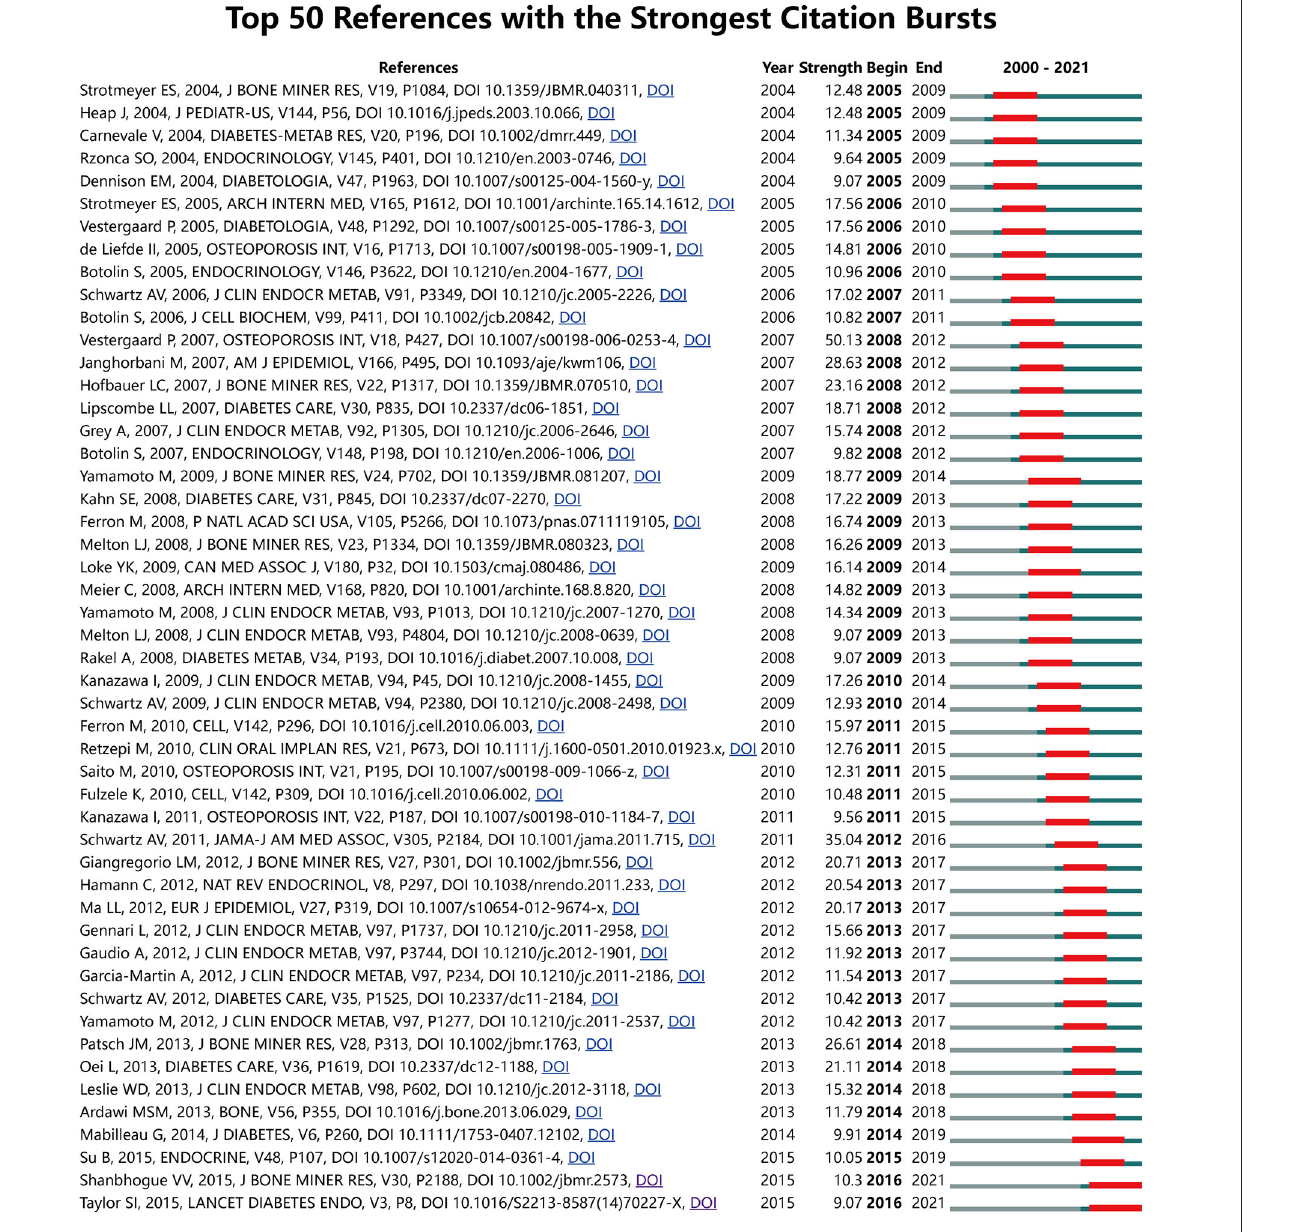
FIGURE 8 | Top 50 references with the strongest citation bursts. The bars in red stands for a burst period for the